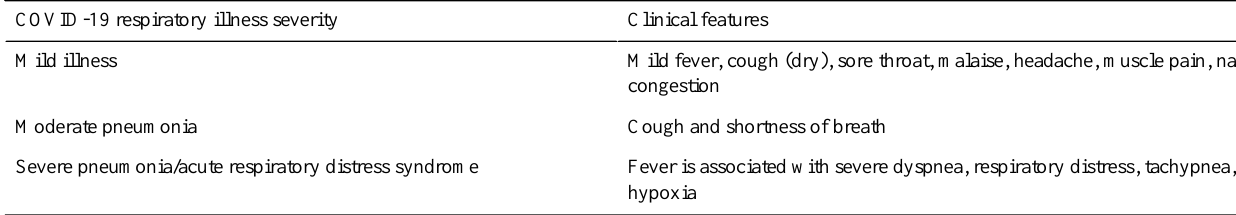
Table 3. Clinical findings according to the COVID-19 respiratory illness severity groups.